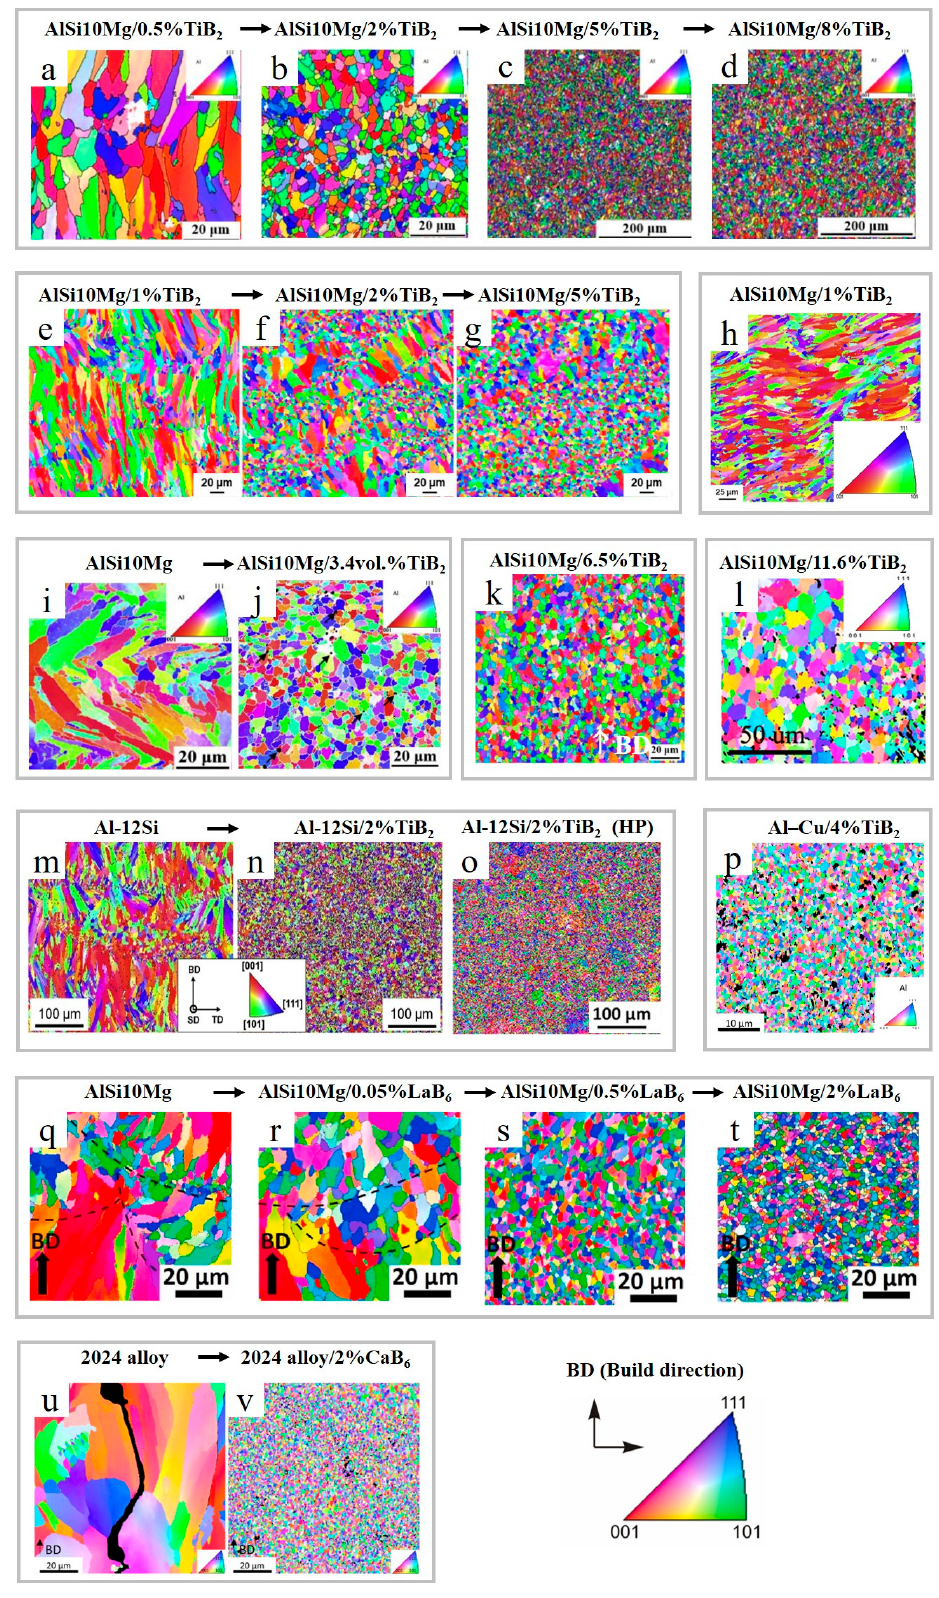
Figure 3. EBSD (electron backscatter diffraction) color maps for LPBF-prepared Al alloys and AMCs reinforced with borides (( a )–( n ) and ( p )–( v )) (subfigure ( o ) represents hot-pressed (HP) sample) (reproduced with permission from [28,59,64,73,77–80,83,84]).